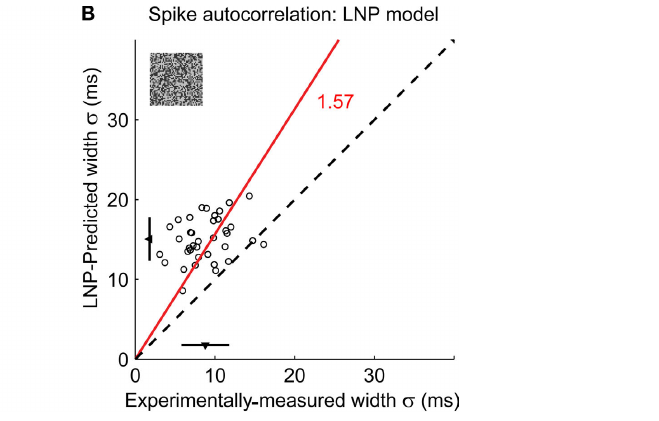
Figure 5 | The gLM captures the fine timing precision of LgN cells in response to spatiotemporal white noise stimuli. (A) Spike autocorrelation widths for all cells ( n = 37), as predicted by the GLM versus experimental measurements. The dashed line has unity slope. For each cell, the spike autocorrelation width is the standard deviation of the Gaussian that best fits the (global) spike autocorrelation function. A fitted line (green) and the corresponding proportionality coefficient are shown, computed between the